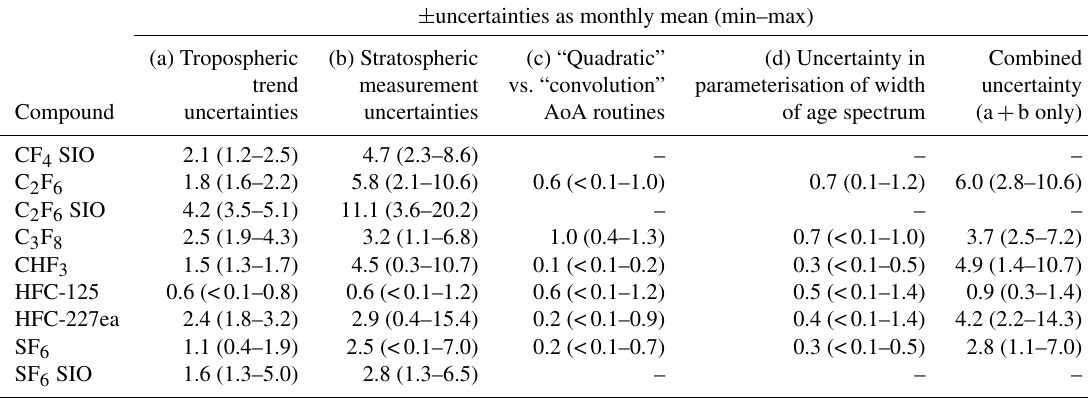
Table 3. Uncertainties ∗ associated with calculating the mean age of air for stratospheric samples. ± uncertainties as monthly mean (min–max)